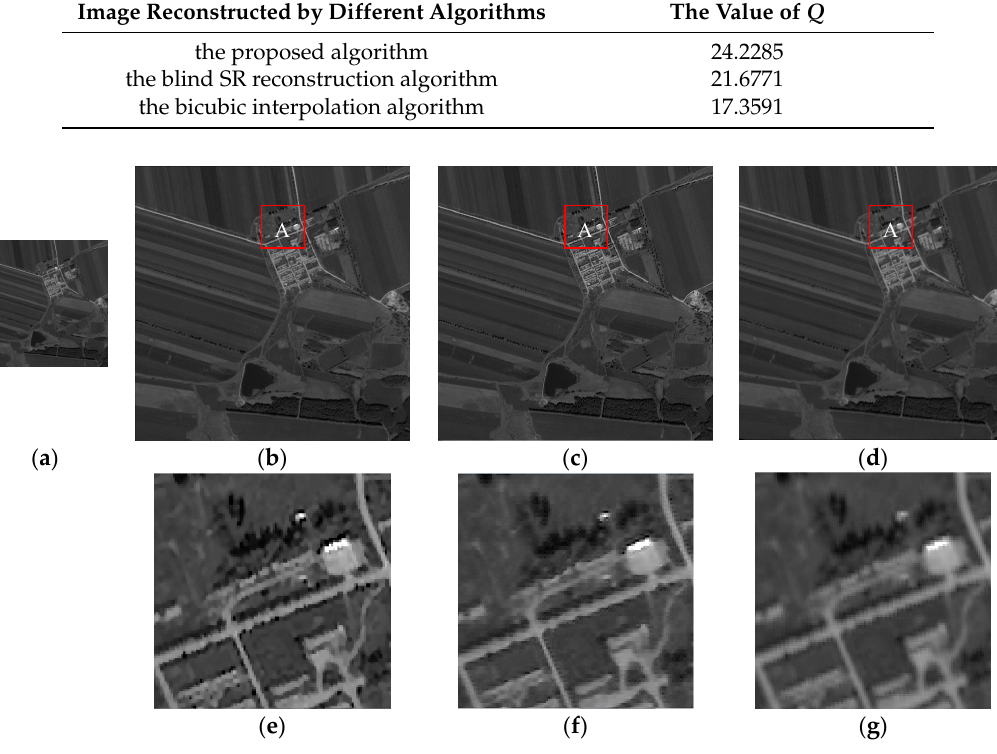
Figure 14. Actual results of the experiments using the three methods. The images enclosed in a red box are the details of the three different algorithms. ( a ) Original LR image; ( b ) image based on the proposed algorithm; ( c ) image based on the blind SR reconstruction algorithm; ( d ) image based on the bicubic interpolation algorithm; ( e ) is the detail of reconstruction in region A by the proposed algorithm; ( f ) is the detail of reconstruction in region A by the blind SR reconstruction algorithm; and ( g ) is the detail of reconstruction in region A by the bicubic interpolation algorithm.